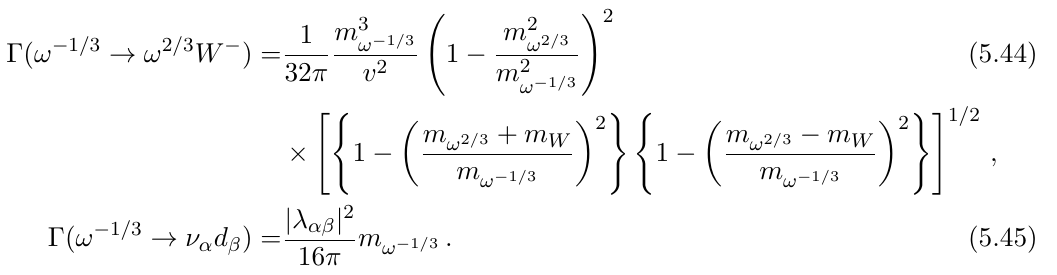
(1). (cid:24) O (cid:23) d are respectively given (cid:11) (cid:12) !